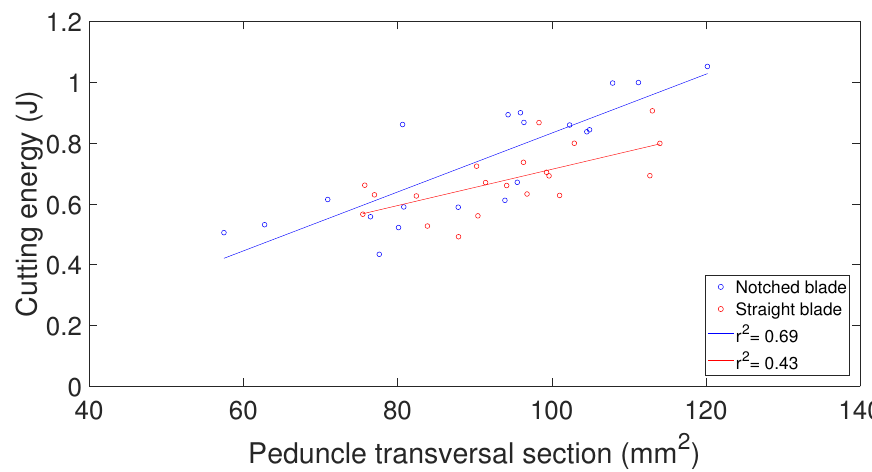
Figure 13. Cutting energy for the notched and straight blades.